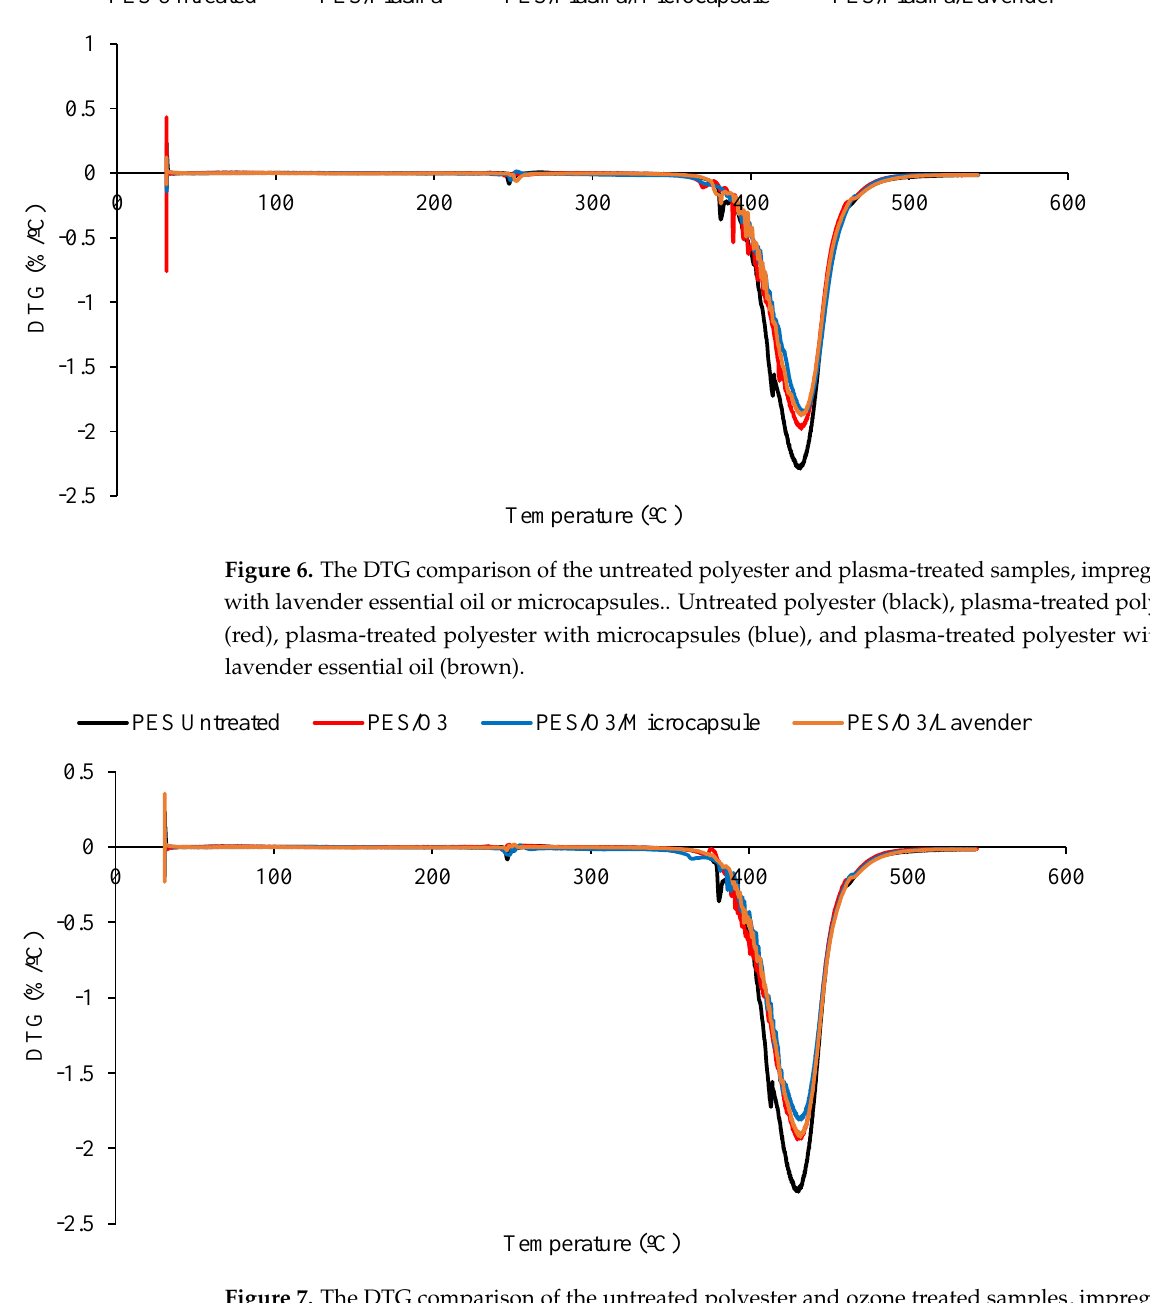
Figure 7. The DTG comparison of the untreated polyester and ozone treated samples, impregnated with lavender essential oil or microcapsules. Untreated polyester (black), ozone-treated polyester (red), ozone-treated polyester with microcapsules (blue) and ozone-treated polyester with the lav- ender essential oil (brown).